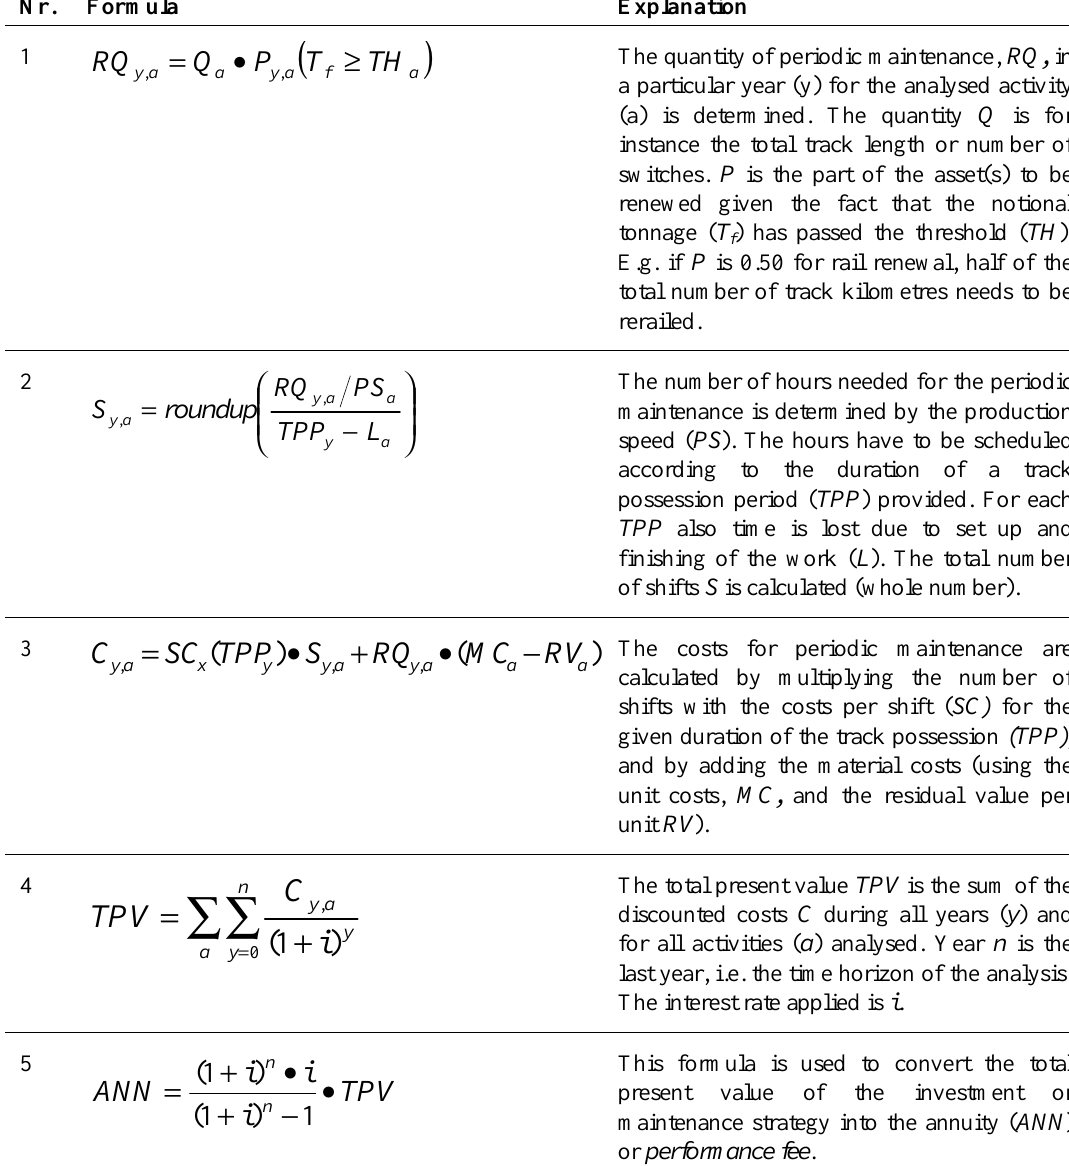
Table 1. Simplified formulas for calculating the annuity of renewals